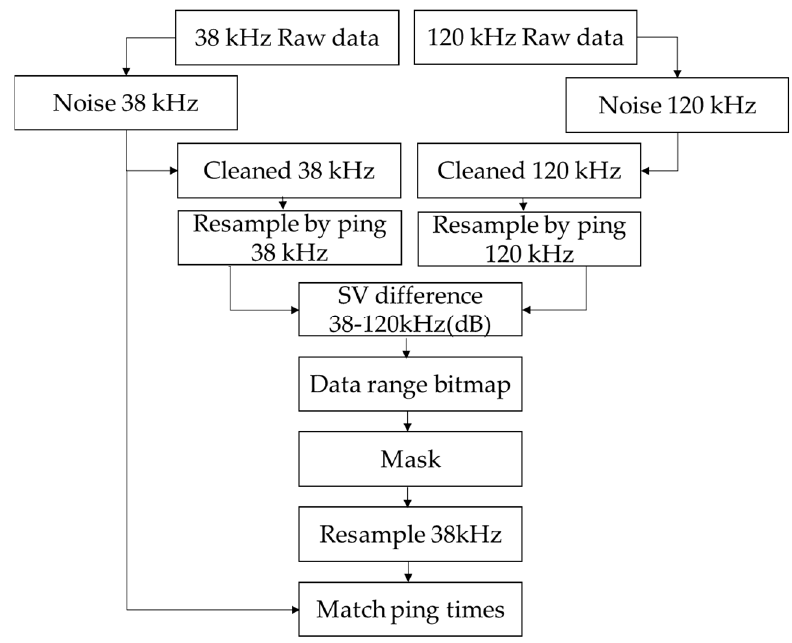
Figure 2. Acoustic data post-processing